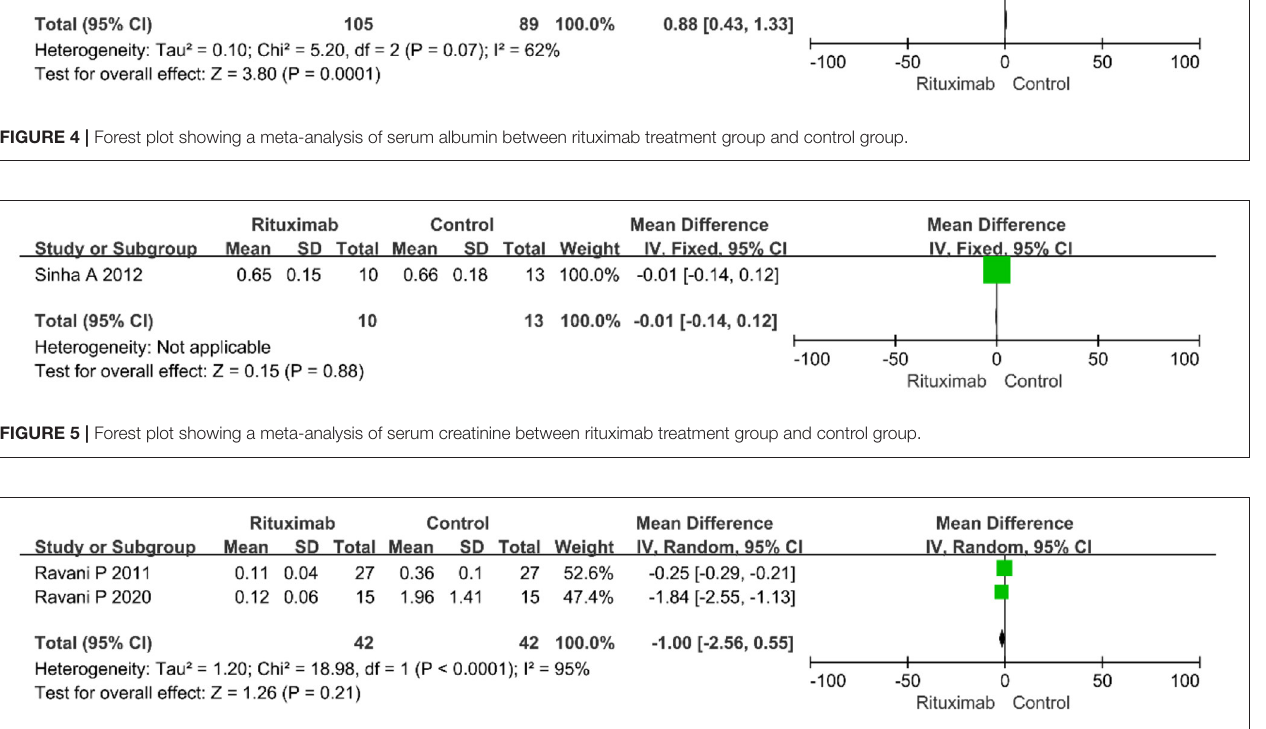
FIGURE 6 | Forest plot showing a meta-analysis of proteinuria between rituximab treatment group and control